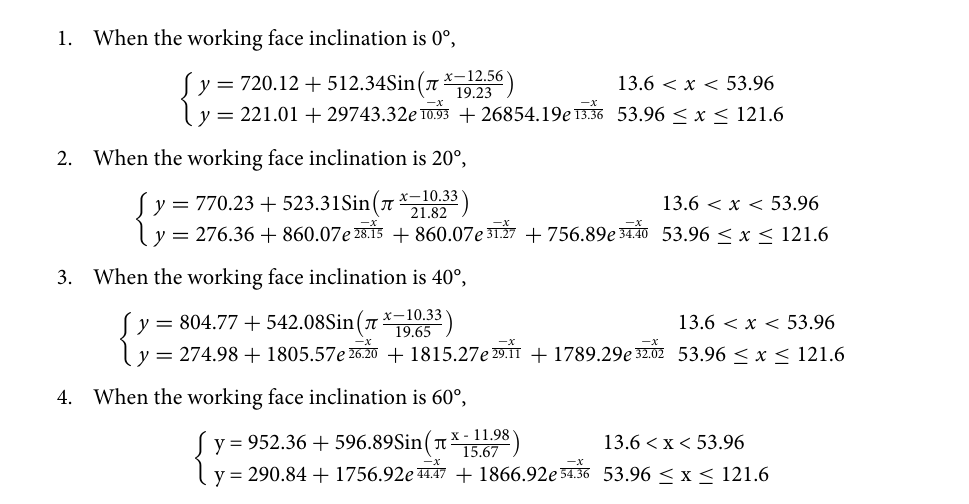
Figure 8. Fitting curve diagram of the sidewalk dust dispersion trend under different working face inclination angles (α = 0°, 20°, 40°,